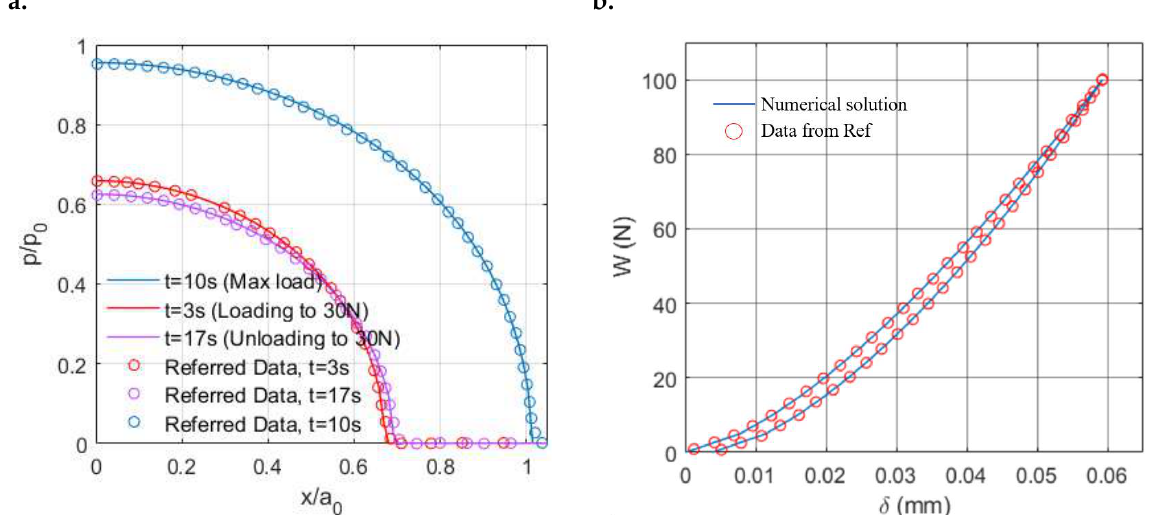
Figure 6. Comparison of the contact solutions from the present model (solid lines) with the results from Chen et al. [11] (scatter) under the triangular-shaped loading conditions: ( a ) Normalized pressure p at different times and ( b ) Evolution of rigid body indentation δ with the varying normal load W .